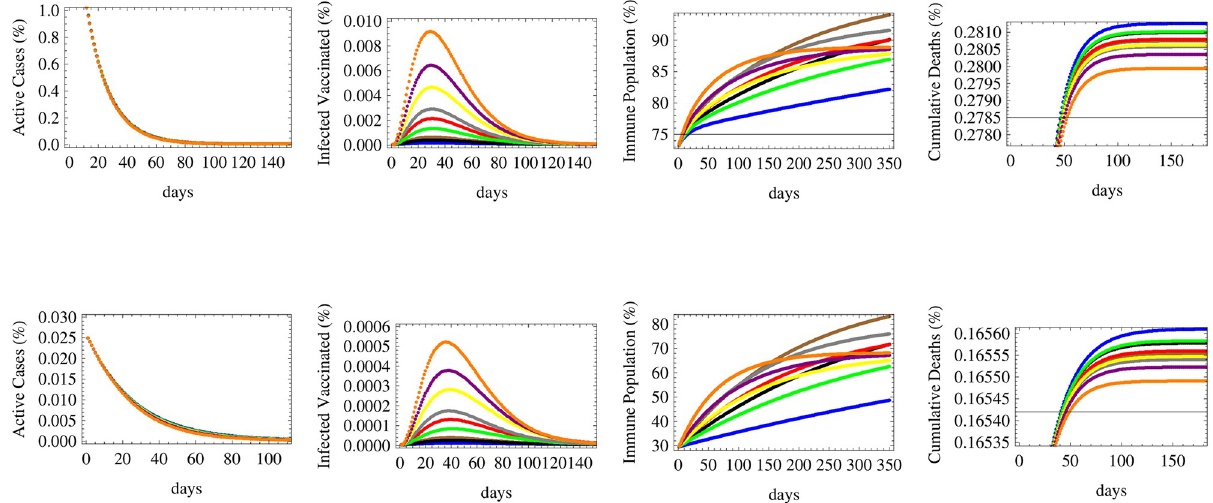
Fig 2. The relative numbers of active cases, infected vaccinated cases, immune population and total cumulative deaths are shown for a low reproductive rate R = 0.7 under initial conditions of: 73.1% vaccinated population 2.0% currently infected and 0.23% dead (upper row, United Kingdom) and 29.2% vaccinated population 0.02% currently infected and 0.16% dead (lower row, South Africa) for nine different vaccination scenarios. The forecast corresponds to vaccine efficacy ( e ) and daily deployment rate ( v ) of: e = 92%, v = 0.5% (in brown), e = 92%, v = 0.3% (in black), e = 92%, v = 0.1% (in blue), e = 72%, v = 0.7% (in gray), e = 72%, v = 0.5% (in red), e = 72%, v = 0.3% (in green), e = 55%, v = 1.5% (in orange), e = 55%, v = 1% (in purple) and e = 55%, v = 0.7% (in yellow).